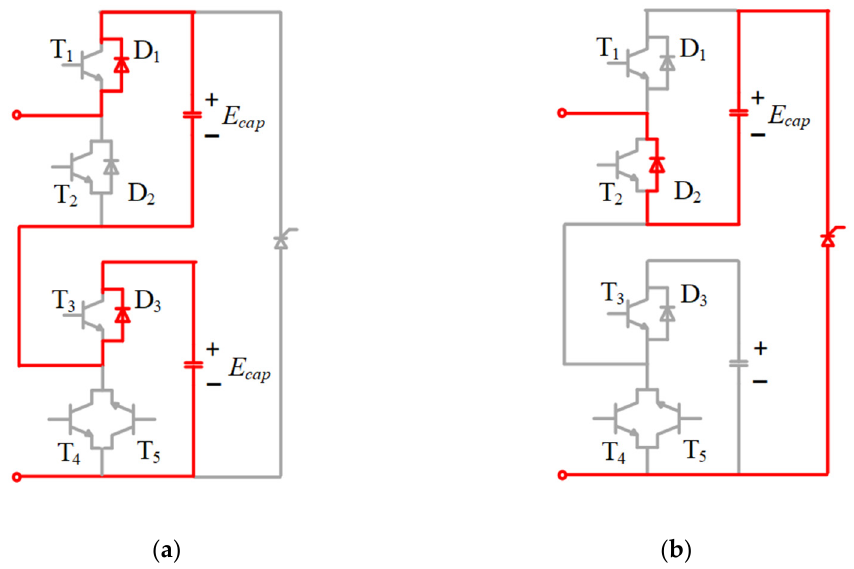
Figure 7. Operation of the BHBSM during the fault state according to the direction of a fault current: ( a ) i f > 0 and ( b ) i f < 0.